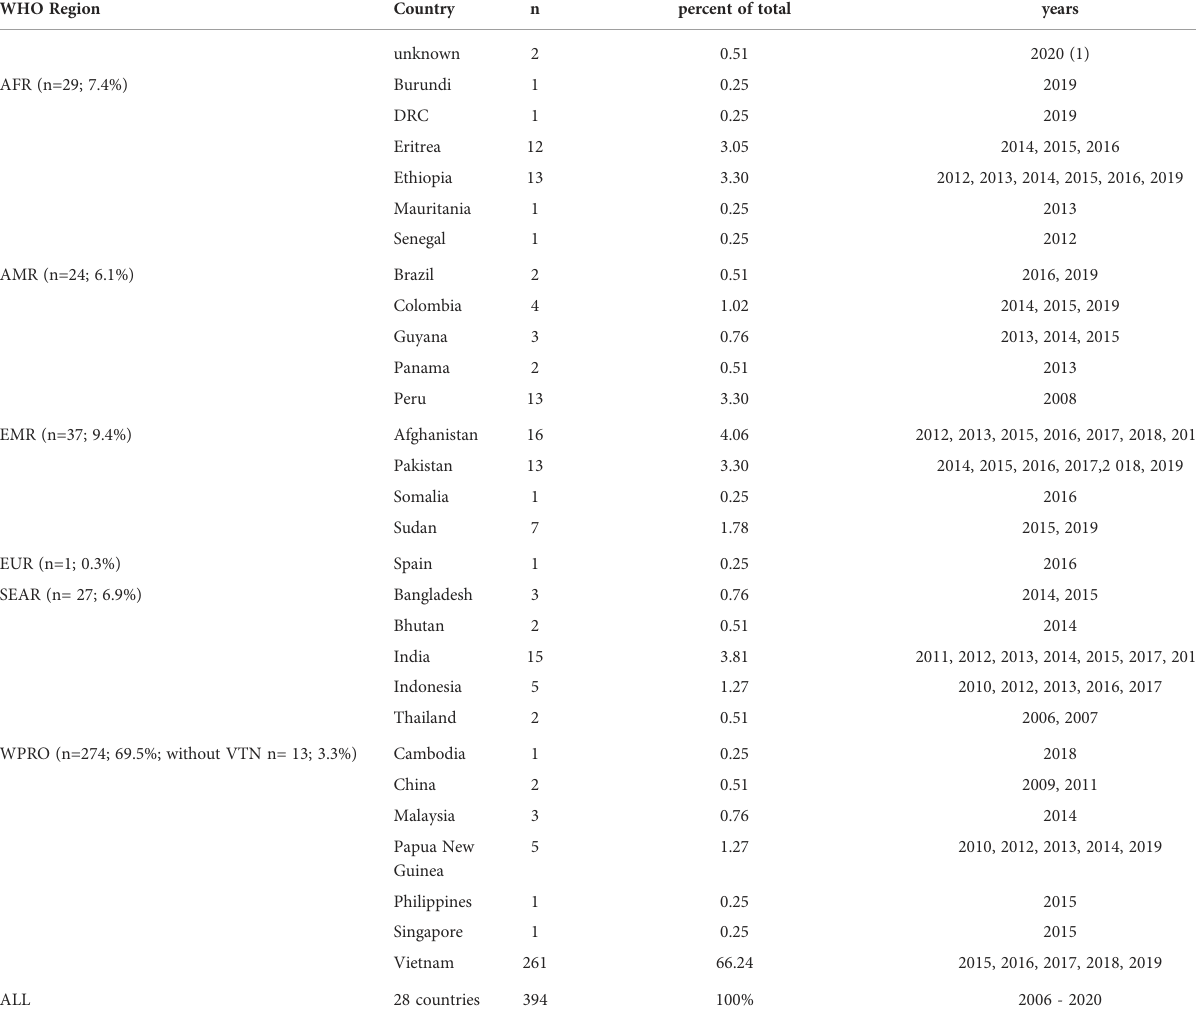
TABLE 2 Overview of good quality (coverage >15 and ≤ 50% genotypes missing) samples included in the Pv AmpliSeq analysis. WHO Region